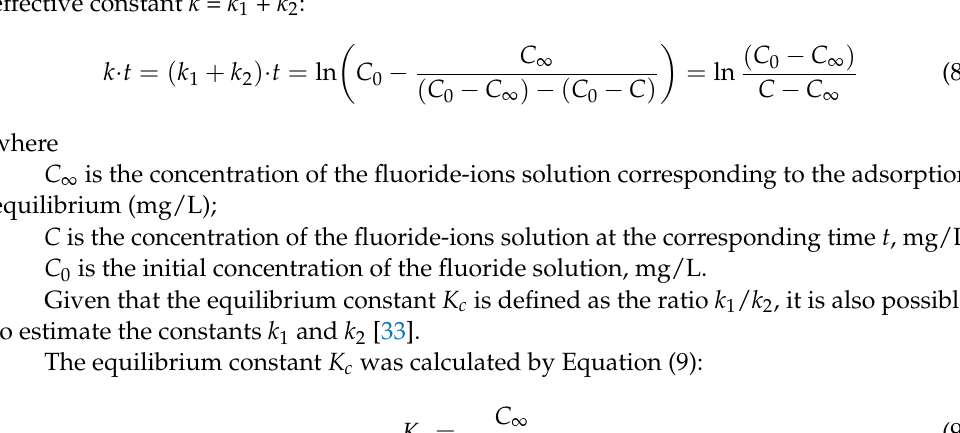
( C 0 − C ∞ ) − t , we determined C − C ∞